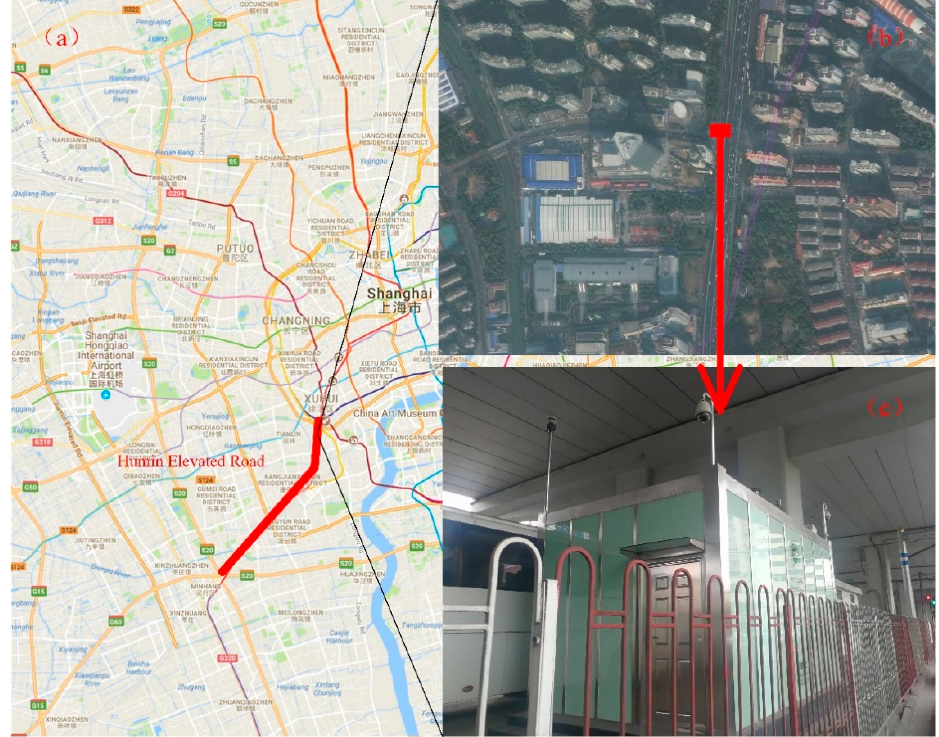
Figure 1. Overview of the monitoring station: ( a ) geographical location of the monitoring station in Shanghai; ( b ) top view of the experimental road; ( c ) picture of the monitoring station.